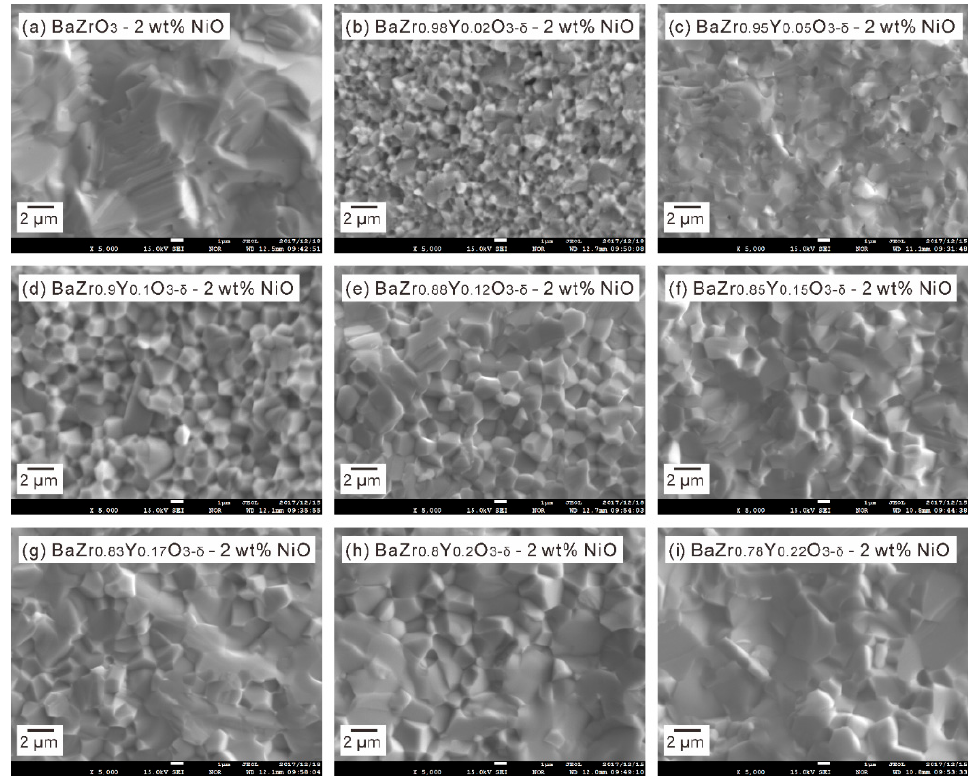
Figure 8. Second electron images of the BaZr 1 − x Y x O 3 −δ -2 wt % NiO ( x = 0, 0.02, 0.05, 0.1, 0.12, 0.15, 0.17, 0.20, 0.22) samples, which were sintered at 1500 ° C in oxygen for 10 h.